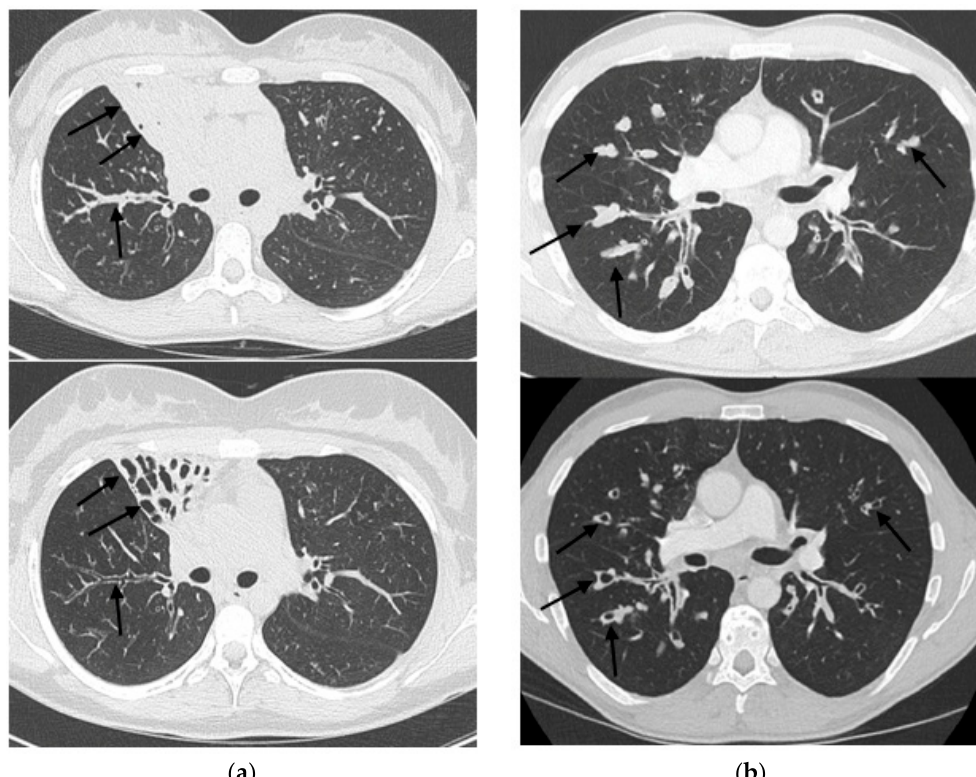
Figure 1. Two examples of CT scan before treatment ( top ) and after treatment ( bottom ) in two patients. ( a ) shows a complete regression of mucous pluggings (black arrows) in a collapsed middle lobe. ( b ) shows a complete regression of distal mucous pluggings (black arrows). The Pearson correlation test found a significant association between improvement in FEV1 and improvement in total score (r = − 0.51, p = 0.002), peribronchial thickening (r =